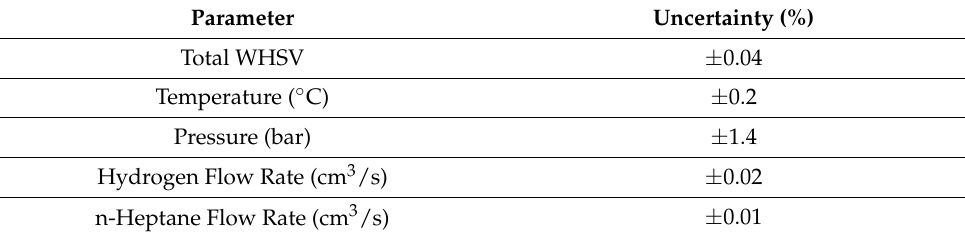
Table 1. Calculated experimental work uncertainties of catalytic reforming parameters.